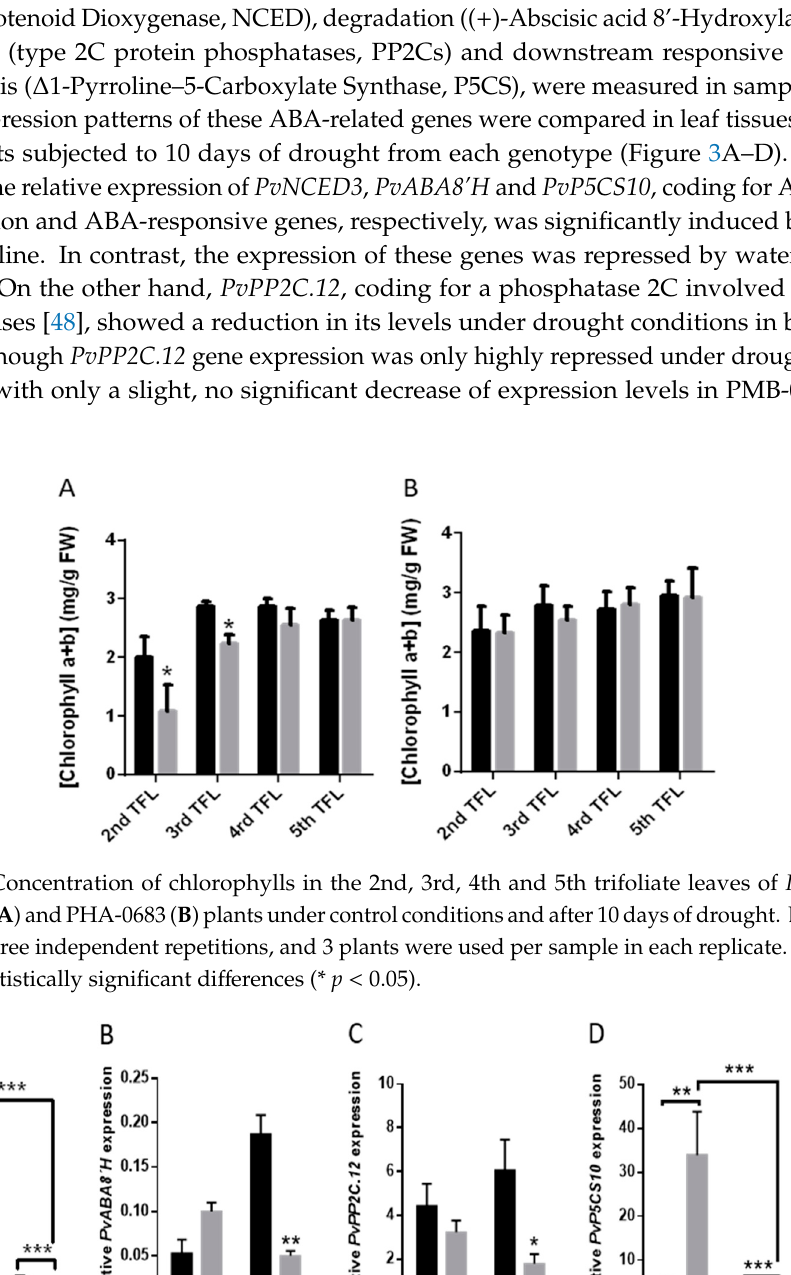
Table 1. Concentration of chlorophyll a, b and total chlorophyll in the 2nd, 3rd, 4th and 5th trifoliate leaves of P. vulgaris PMB-0220 and PHA-0683 subjected to well-watered and water deficit conditions for 10 days.